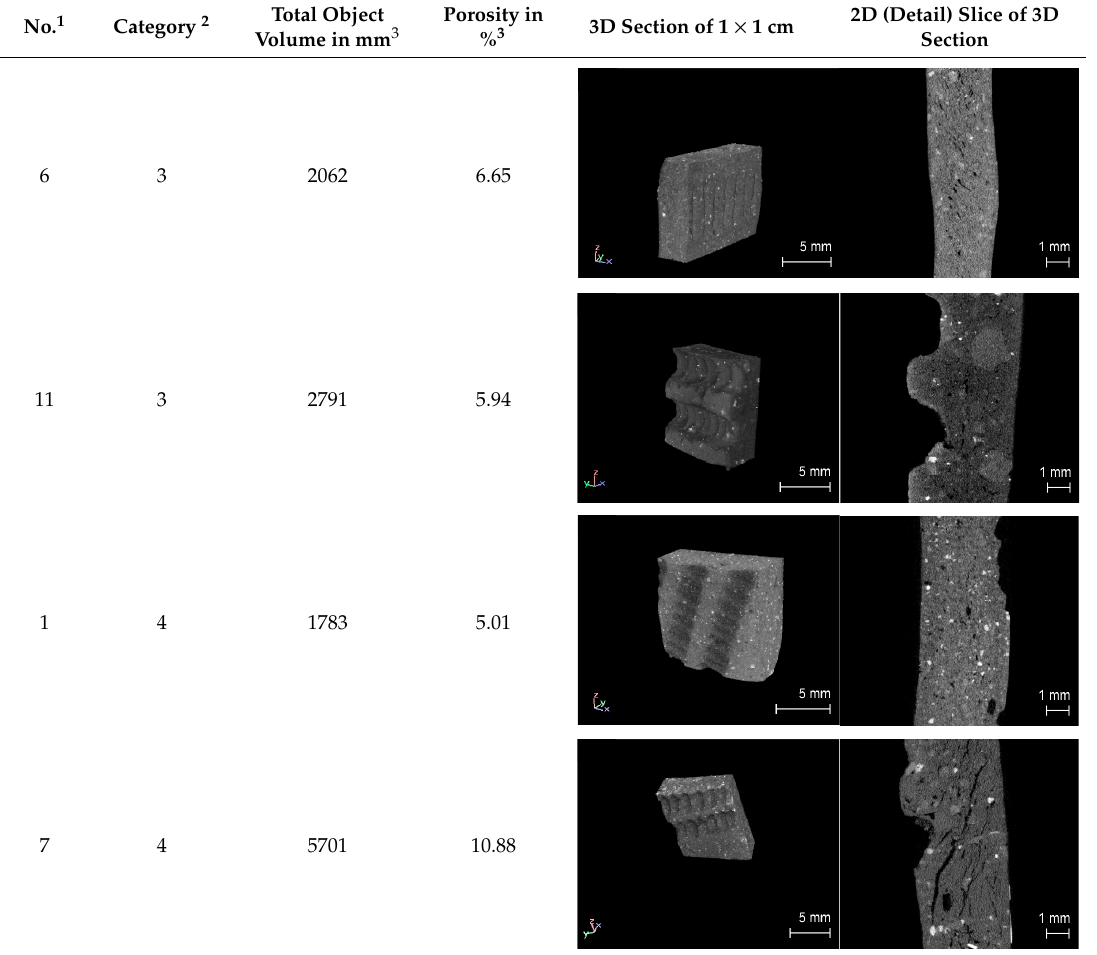
Table 5. X-ray microtomography scans of neolithic samples and morphometric information.